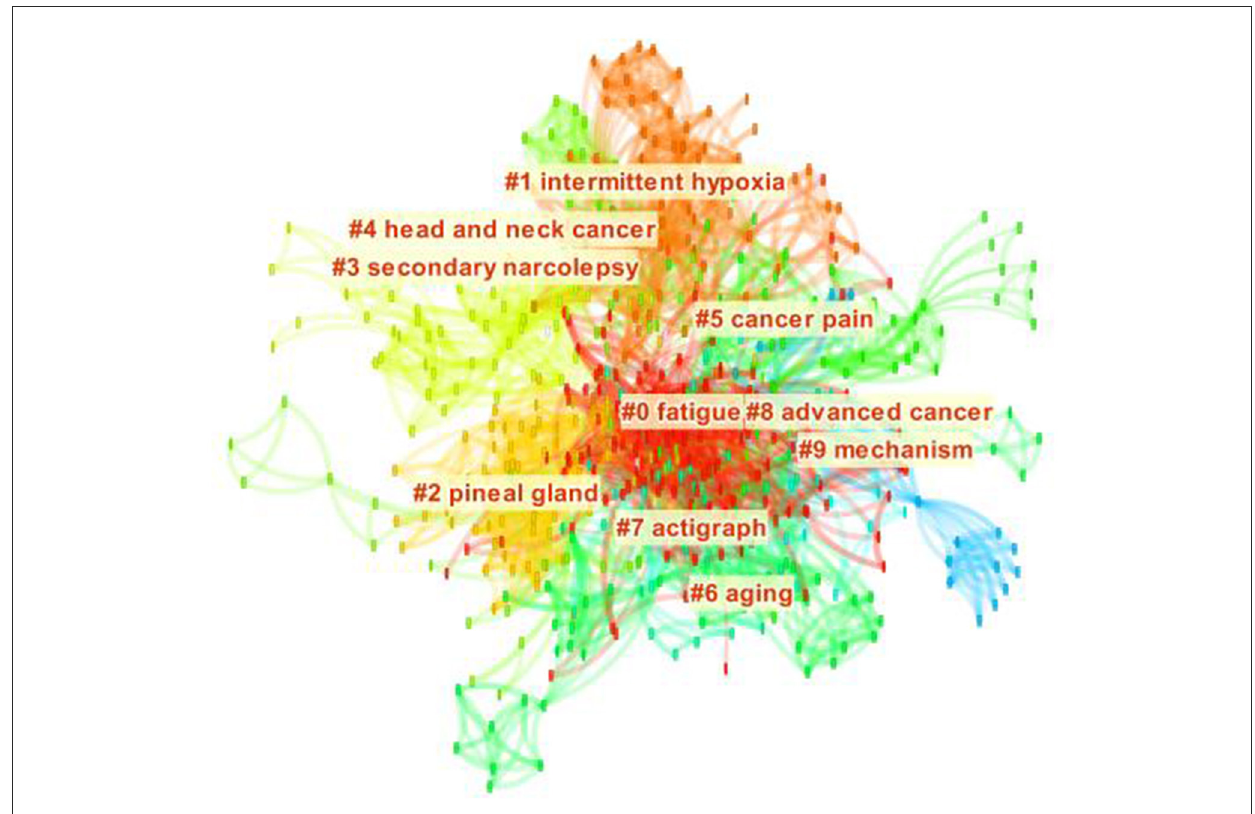
FIGURE5 Cluster map of keywords on cancer and sleep research.